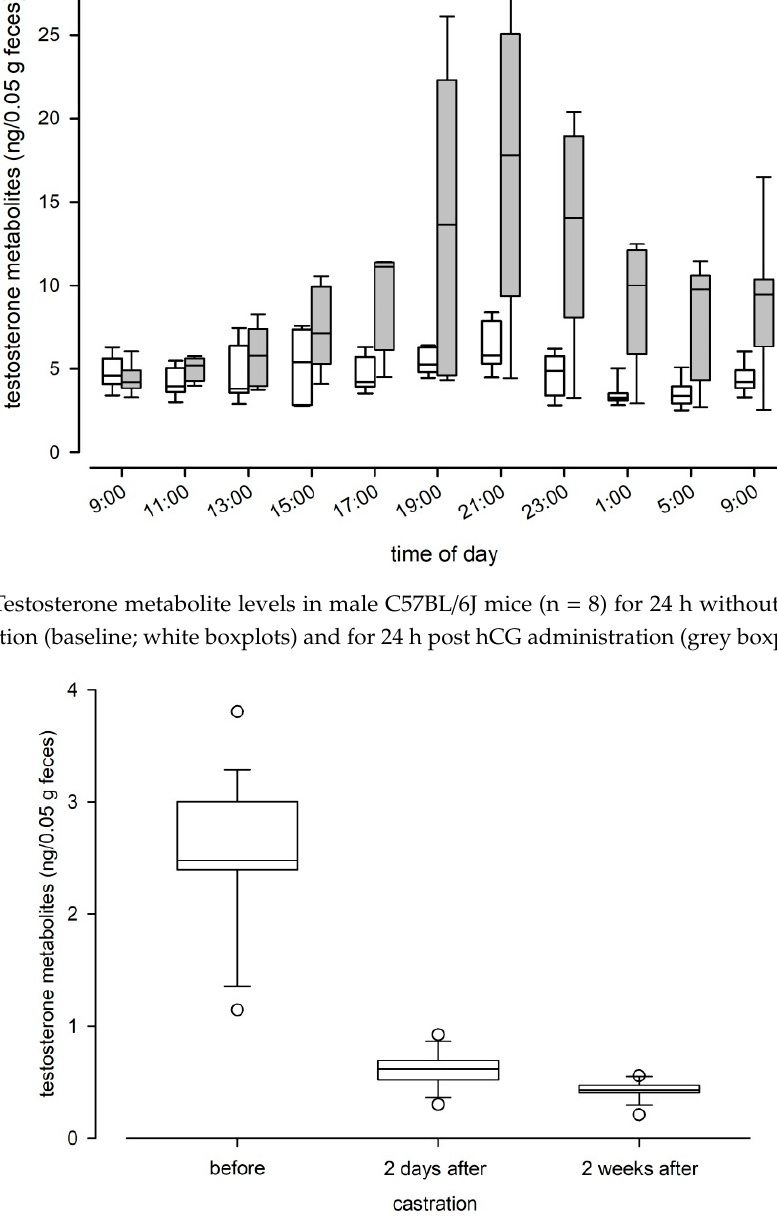
Figure 6. Testosterone metabolite levels in male C57BL/6J mice before, two days and two weeks after castration. Dots are outliers with values between 1.5 ‒ 3.0× interquartile range.